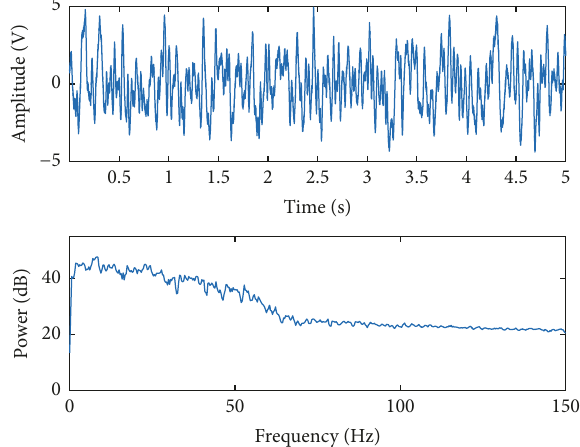
Figure 16: Received signal and power spectrum when the trans- ducer frequency is 35 Hz and flow meter value is 0.71 m/s.